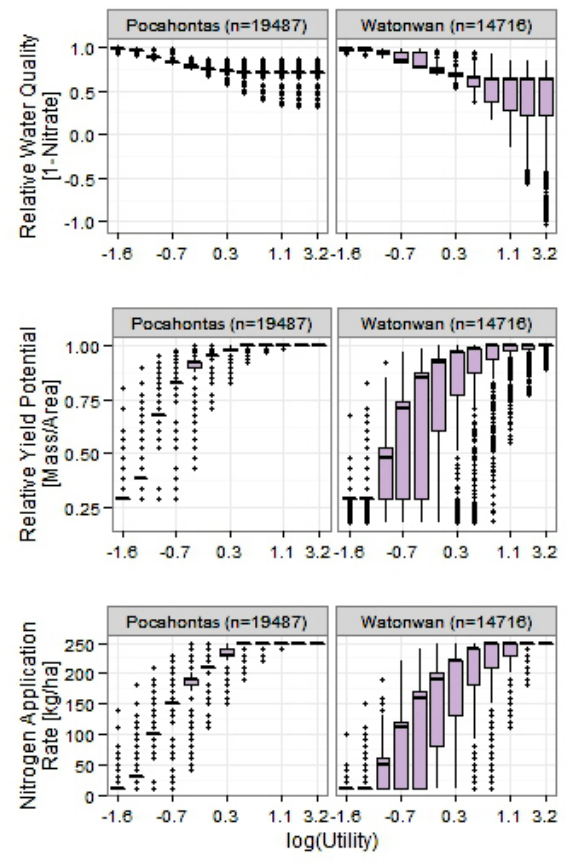
Fig. 5 . Plots illustrate the range of potential responses across utilities based on context. Pocahontas County illustrates a county with a tight response across utility preferences, whereas Watonwan County increases in variability as utility preference for yield